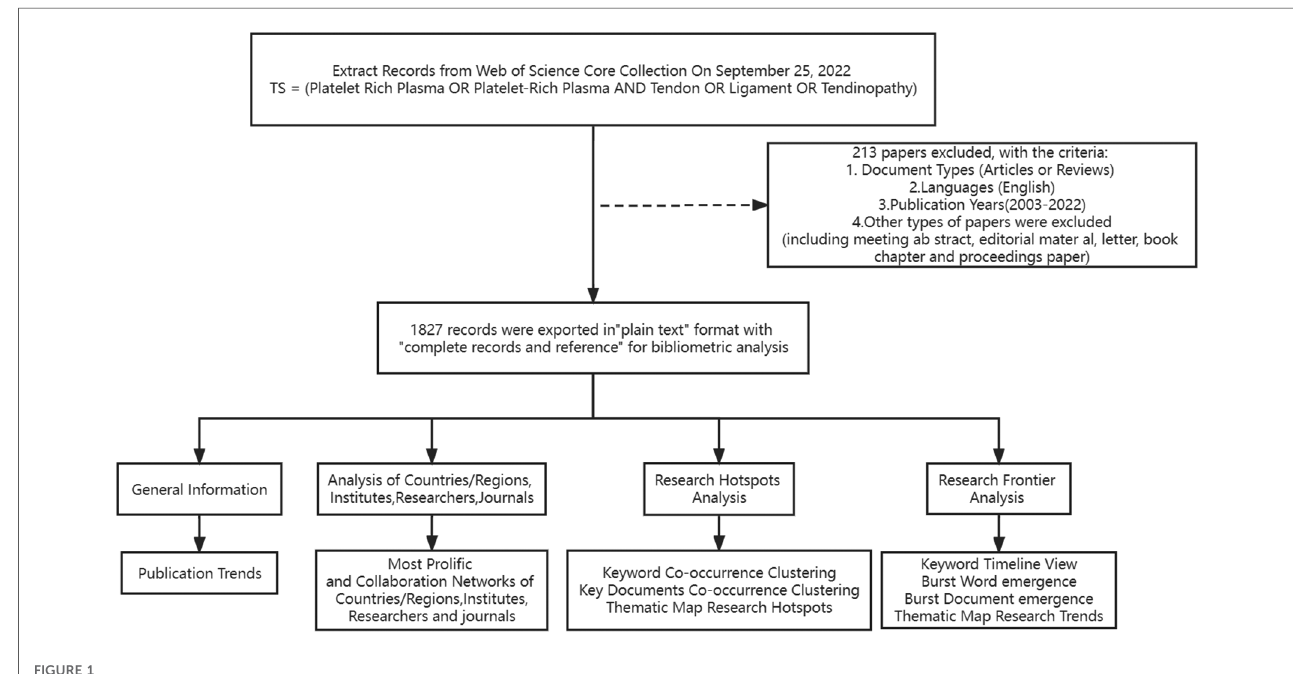
FIGURE 1 Work fl ow